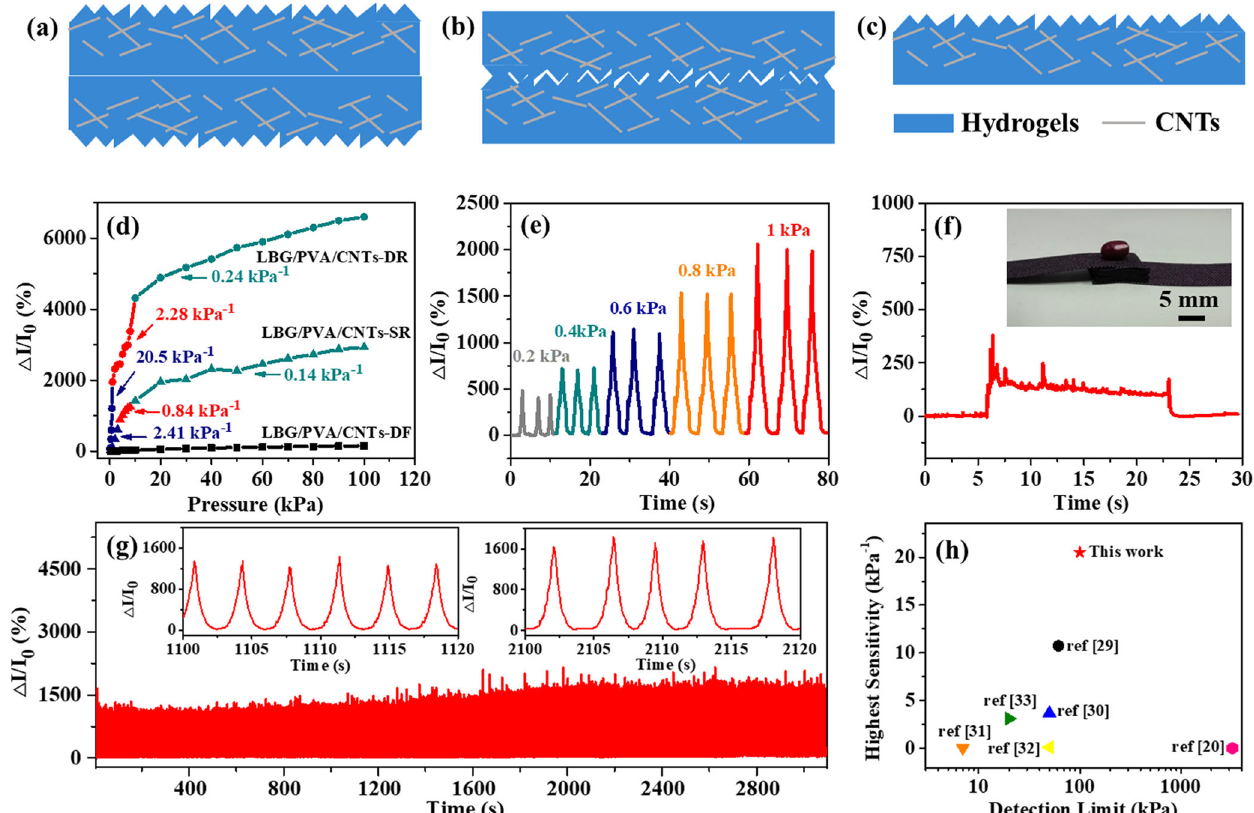
Fig. 2 Evaluation of the performance of the sensor. Schematic illustration of a LBG/PVA/CNTs-DR, b LBG/PVA/CNTs-DF and c LBG/PVA/CNTs- SR hydrogels. d The relative current changes for the sensors with LBG/PVA/CNTs-SR, LBG/PVA/CNTs-DF and LBG/PVA/CNTs-DR hydrogels; the slope of the curve represents sensitivity. e The I-t curves of the sensor with LBG/PVA/CNTs-DR hydrogels under serial pressures below 1 kPa. f Response of the sensor with LBG/PVA/CNTs-DR hydrogels to the loading and removal of a small weight (a grain of beans, corresponding to a pressure below 0.1 kPa). g Durability test of the sensor with LBG/PVA/CNTs-DR hydrogels for 1000 cycles under 0.8 kPa. h Detection limit and sensitivity of our piezoresistive sensor with LBG/PVA/CNTs-DR hydrogels in comparison with piezoresistive sensors based on hydrogels as reported in refs. 20,29 – 33